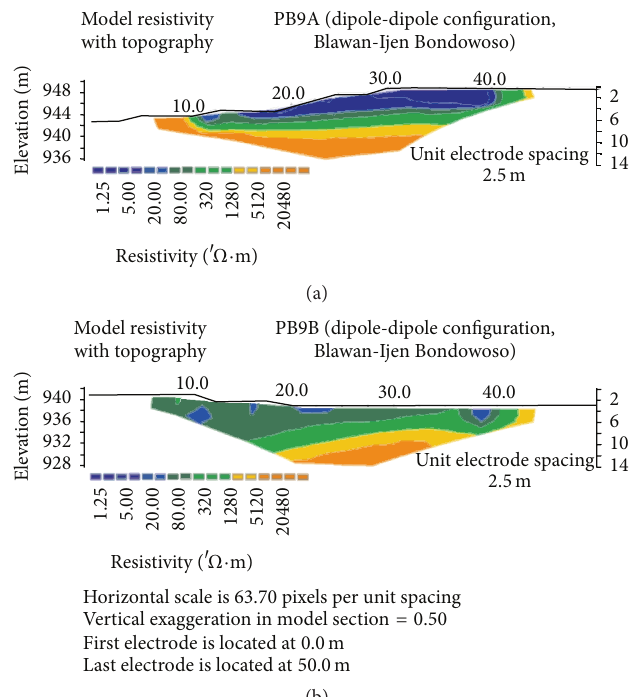
Figure 13: 2D Resistivity Mapping and GPR amplitude slice in locations (a) PB9A and (b) PB9B.